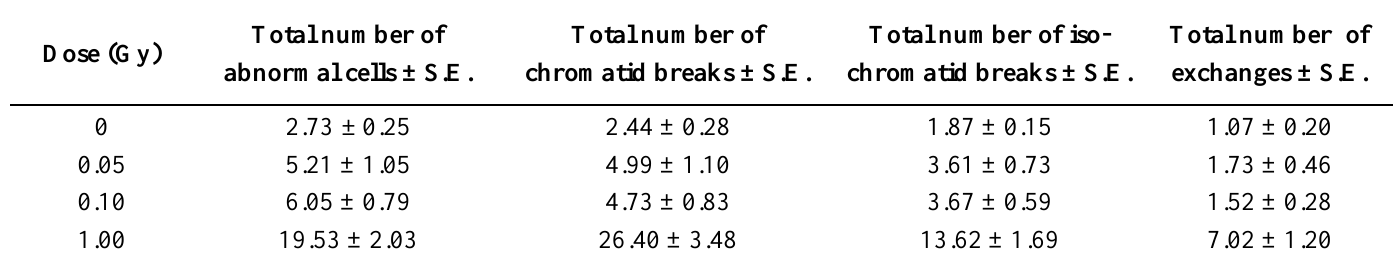
Table 4. Average square root transformation values (  X +  (X+1)) of mean aberrations in 100 cells scored ± standard error of the mean (S.E.) derived from the raw data of the frequencies of each type of aberration, including abnormal cells as shown in Table 2 (4 h